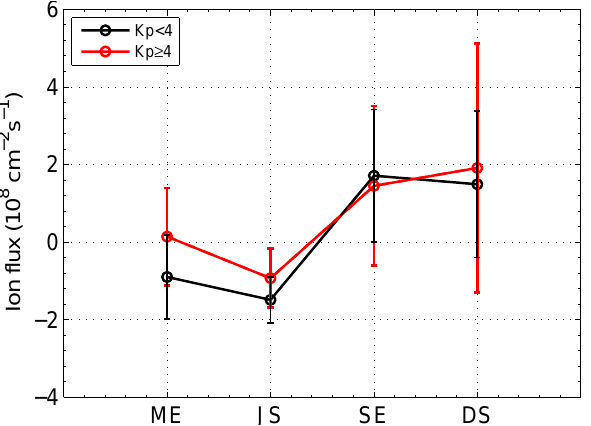
Fig. 10. Seasonal variation of the upflow flux at the key MLat at 800km altitude for Kp < 4 and Kp ≥ 4. The bars show the standard deviations of